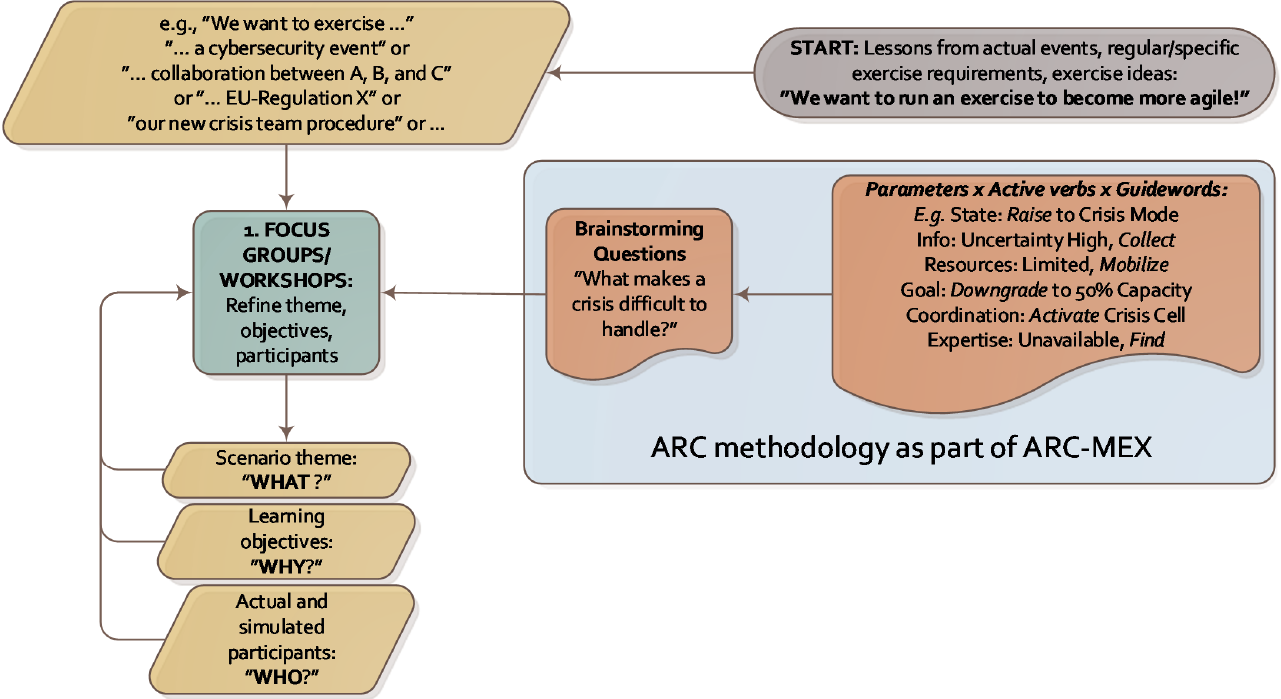
Figure 1. A detailed overview of steps and products of step 1 in the ARC-MEX